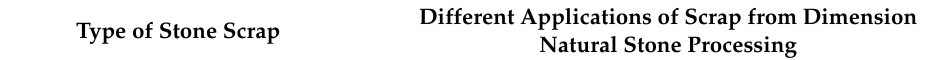
Table 5. Different applications of scrap from dimension natural stone processing (own work based on Shamrai et al. [17] and Shirazi